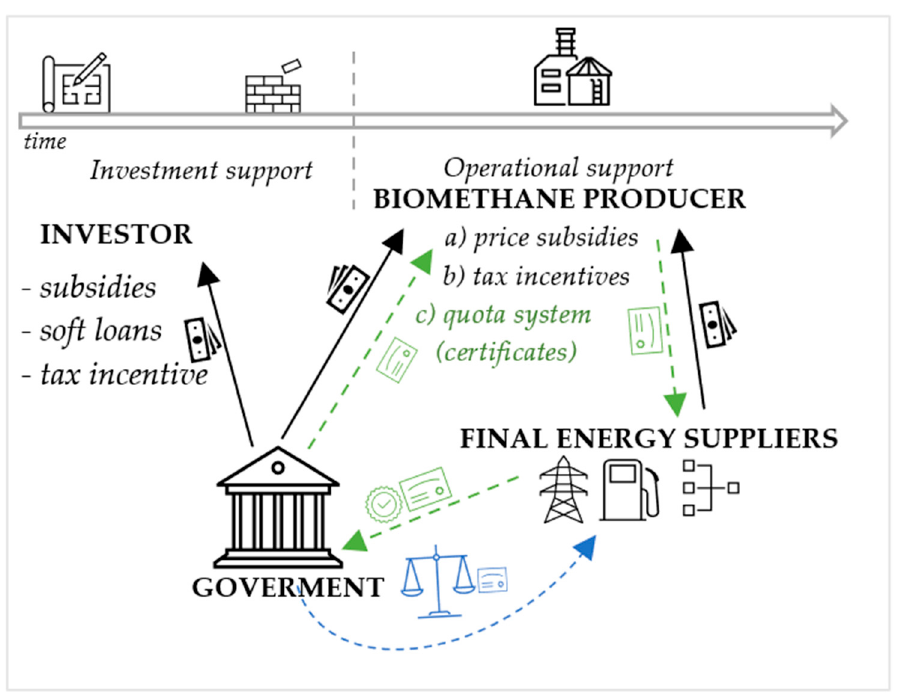
Figure 14. Schemes of biomethane support systems. Source: Own elaboration based on Frishte et al., 2022 [5].